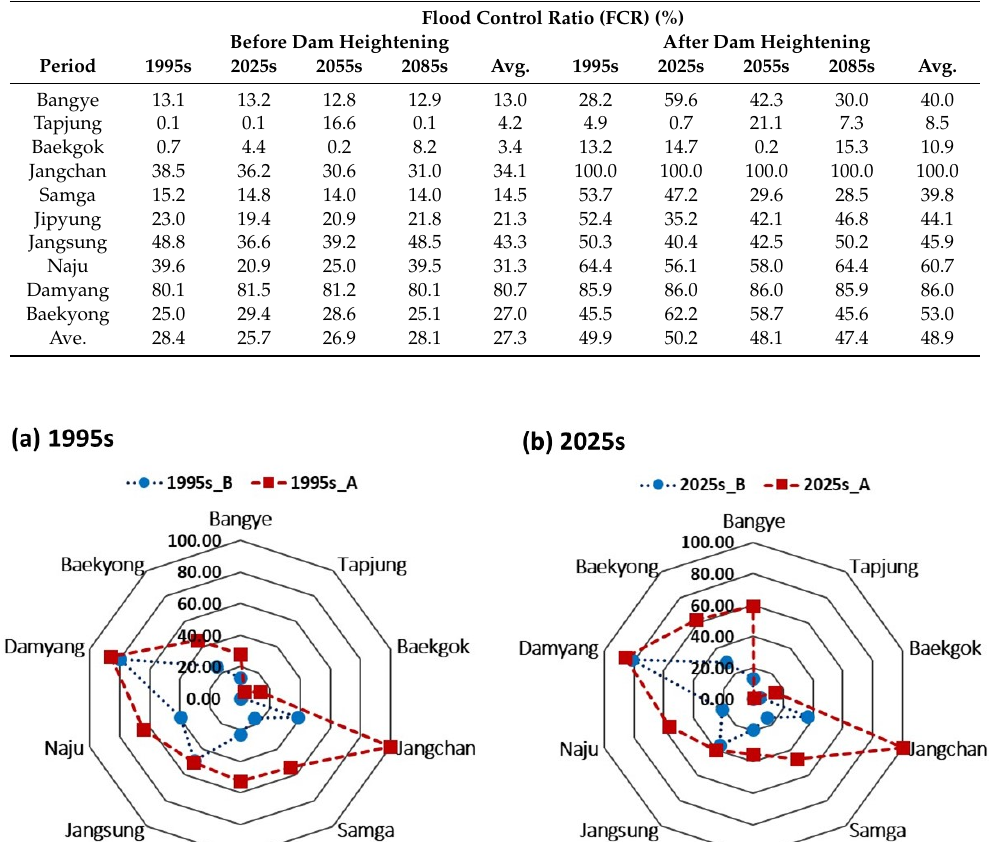
Table 4. Adaptive capacity indicators for four periods and reservoirs. Flood Control Ratio (FCR) (%) Before Dam Heightening After Dam Heightening